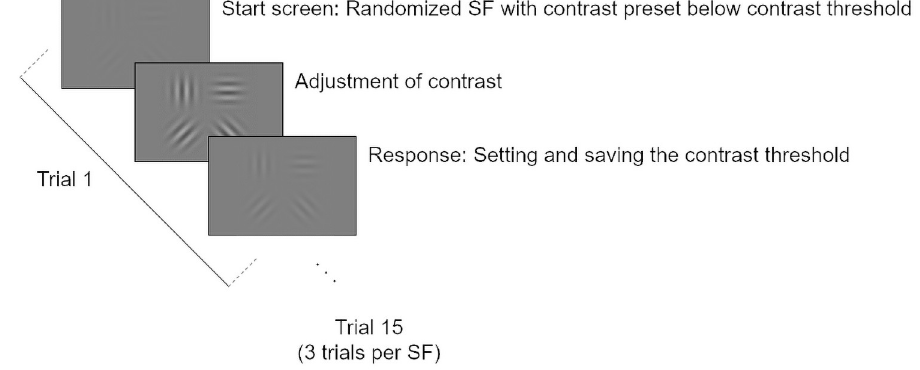
Fig 2. Psychophysical procedure of the new contrast sensitivity (CS) test (Adjustment CST) following the method of adjustment and a total of 15 trials, which means all five selected spatial frequencies were measured three times.